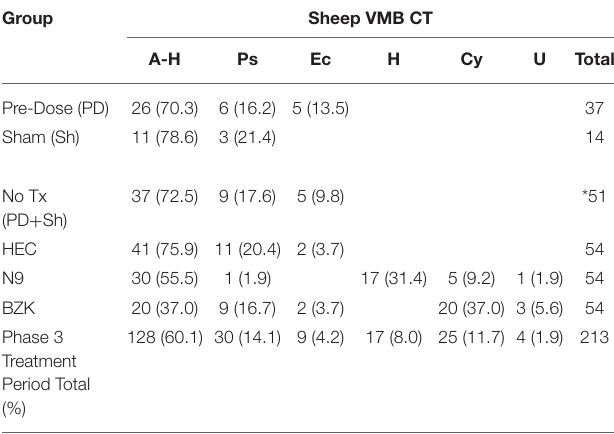
TABLE 1 | Phase 3 vaginal microbiome community type (VMB CT) distribution, D1–D9 (main period). Group